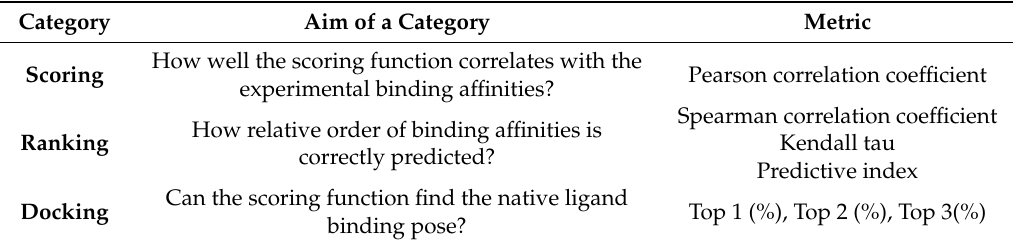
Table 4. Summary of CASF-2016 benchmark